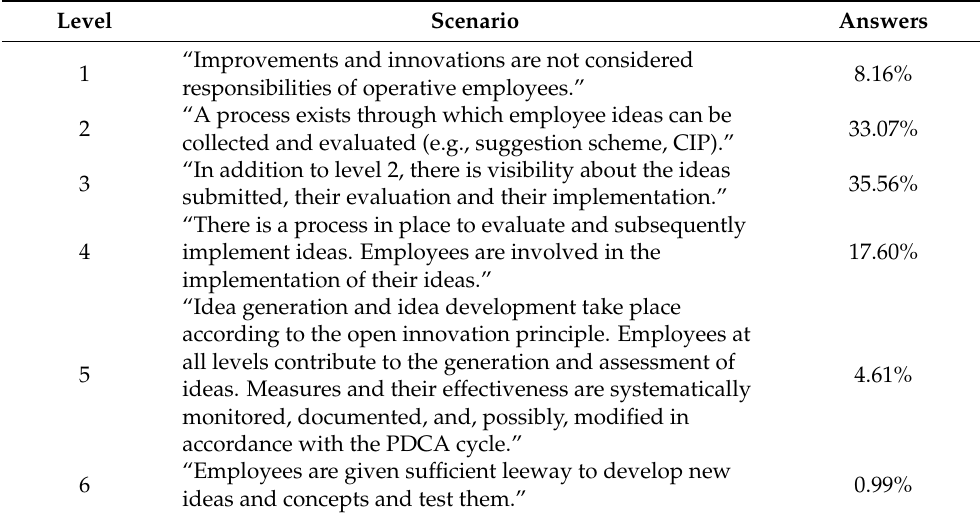
Table 5. Results for the capability “innovation process”.